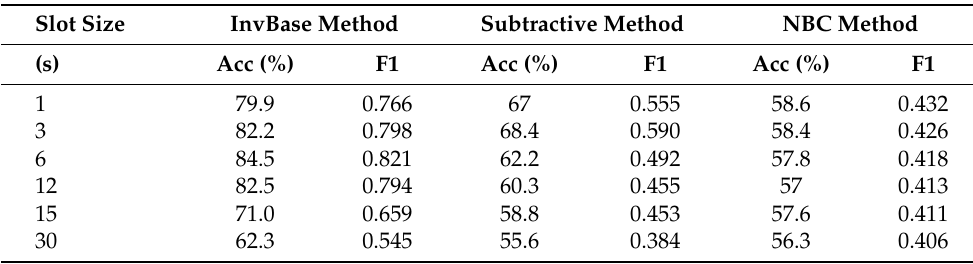
Table 6. Valence classification accuracies and F1 scores of InvBase, subtractive, and NBC methods using SVM with various slot